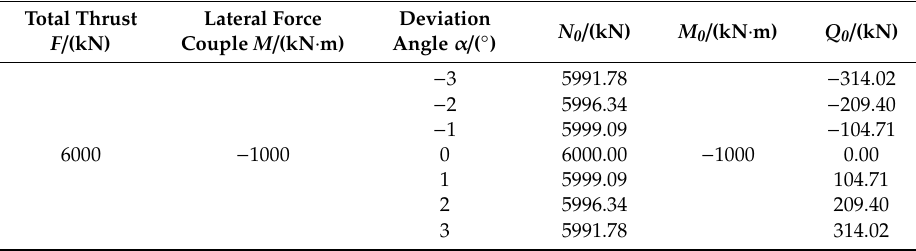
Table 4. The initial parameters under di ff erent jack thrust deviation